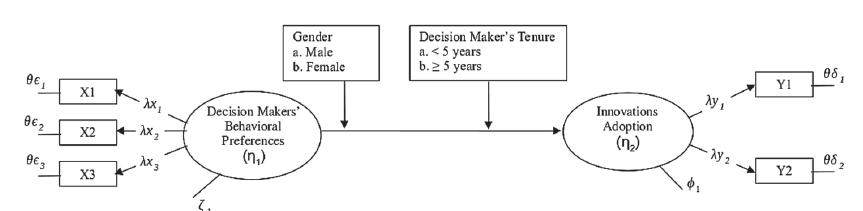
Fig. 4. The measurement model of the effect of moderation variables on the relationship of behavioral preferences of decision-makers and innovations